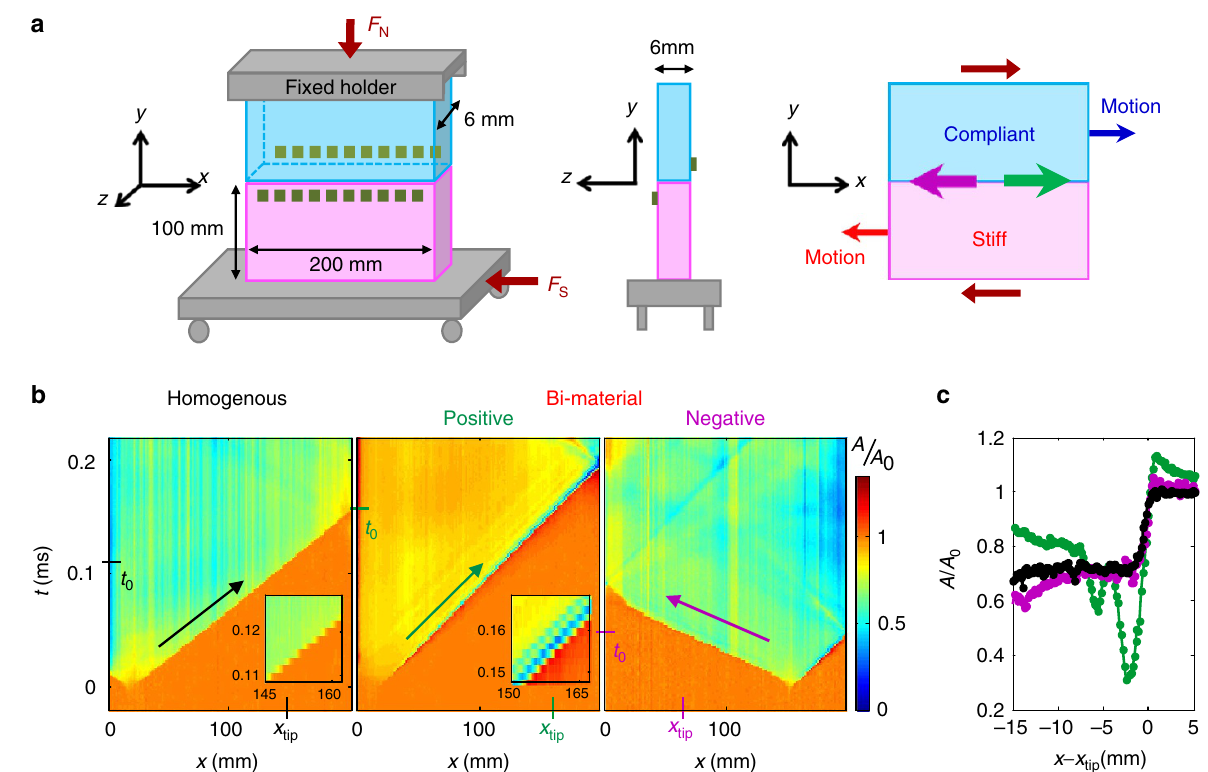
Figure 1 | Experimental system and comparison of rupture profiles. ( a ) Twenty rosette strain gauges (green squares) are mounted E 2mm above and beneath the frictional interface (left), on opposing block faces (centre). Green (purple) arrows define positive (negative) rupture propagation directions as parallel (anti-parallel) to the direction of the motion of the compliant material. ( b ) The real contact area, A ( x , t ) (normalized before nucleation at t ¼ 0), along the 200mm quasi-1D interface. Insets: magnified sections of A ( x , t ). ( c ) A ( x (cid:2) x tip ) measured around rupture tip locations, x tip, denoted in a ; (black) PMMA on PMMA (homogenous system), C f ¼ 0.94 C R , F N ¼ 3,402N, (green) Polycarbonate (PC) on PMMA (bimaterial system) for rupture in the positive direction, C f ¼ 0.99 C S soft , F N ¼ 3,863N, and (purple) leftward supershear rupture in the negative direction, C f ¼ 0.92 C L soft , F N ¼ 3,553N. Negative direction propagation was reversed for